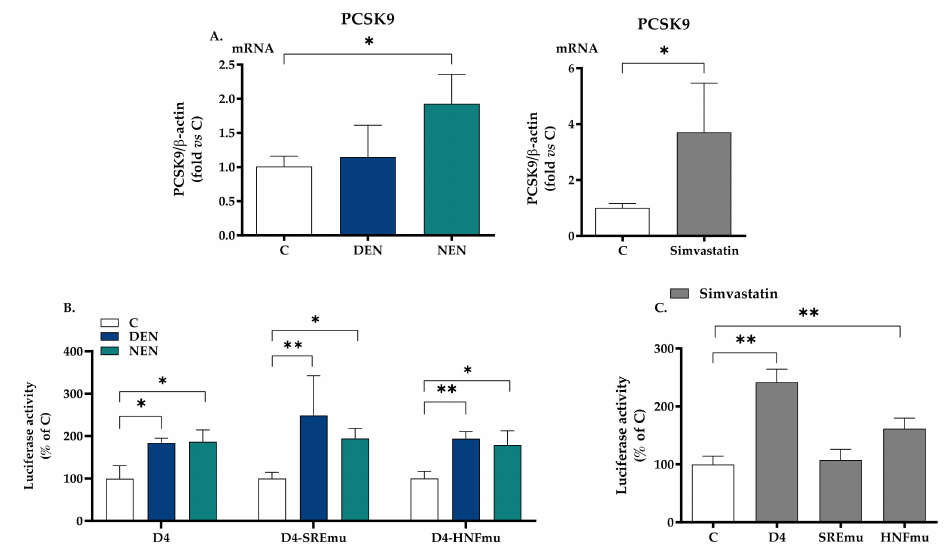
Figure 2. Impact of soy peptides on PCSK9 gene expression and transcriptional activity. Panel ( A ) shows the gene expression of PCSK9 in HepG2 cells incubated with YVVNPDN DEN (350 µ M) and YVVNPDN NEN (350 µ M) in MEM supplemented with 10% FBS for 24 h. Simvastatin (20 µ M) was used as a positive control. At the end of the incubation, total RNA was extracted. Panels ( B , C ) show HepG2 cells transfected with pGL3-PCSK9-D4, pGL3-PCSK9-SREmut, and pGL3-PCSK9-HNF1mut. The day after the transfection, the medium was replaced by MEM containing 10% LPDS supplemented with YVVNPDN DEN (350 µ M) and YVVNPDN NEN (350 µ M) and the specific luciferase activity was determined. Panel ( C ) shows luciferase activity upon treatment with simvastatin. At least three independent experiments were conducted. * p < 0.05 versus control (ANOVA) and ** p < 0.01 versus control (ANOVA). C, control (medium alone). LPDS, lipoprotein deprived serum; HNF1, hepatocyte nuclear factor-1; PCSK9, proprotein convertase subtilisin/kexin type 9; SRE, sterol regulatory element. Simvastatin has been used as a positive control ( C ). DEN stands for YVVNPDN DEN and NEN stands for YVVNPDN NEN